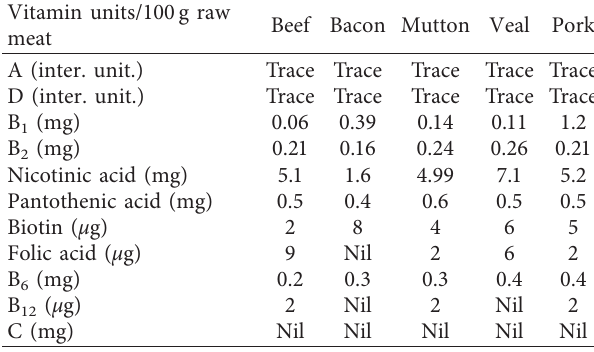
Table 4: Vitamin content of various raw